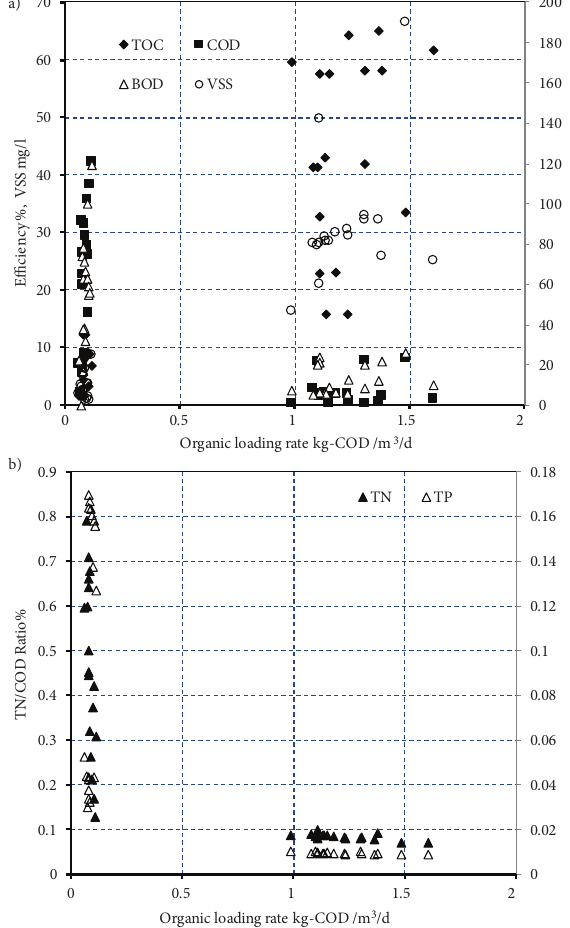
Figure 7. Hybrid biological reactor performance under anaerobic high flow scenario: a) organics removal efficiency and VSS concentration versus organic loading rate; b) TN/ COD, TP/COD, versus organic loading